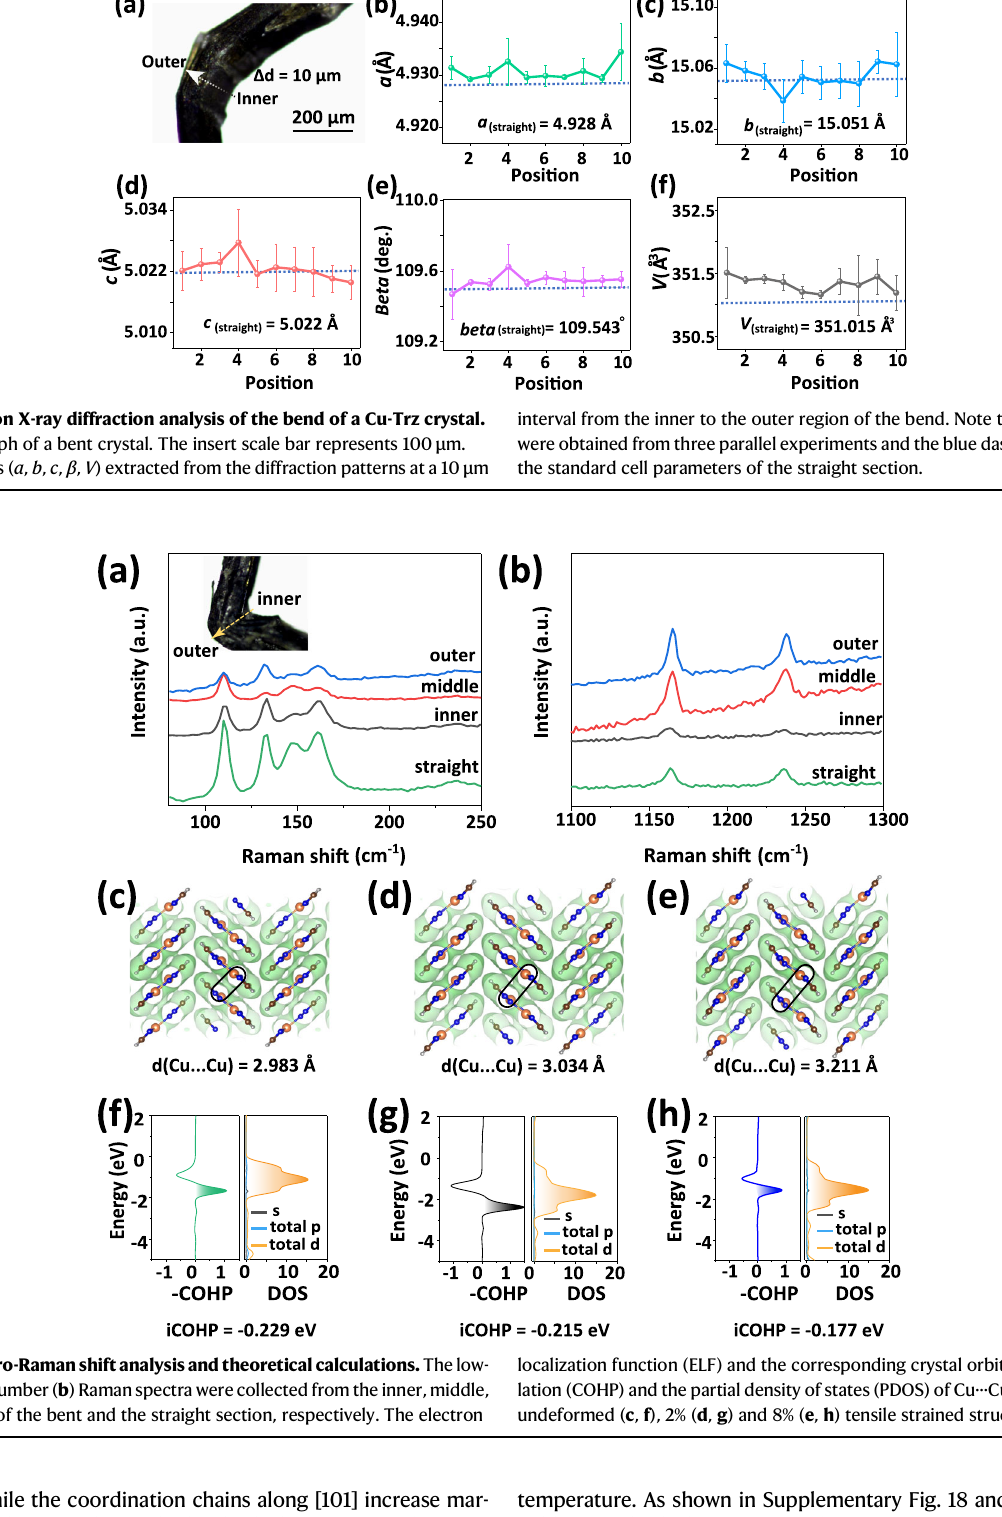
localization function (ELF) and the corresponding crystal orbital Hamilton popu- lation(COHP)andthepartialdensityofstates(PDOS)ofCu···Cuinteractionsofthe undeformed ( c , f ), 2% ( d , g ) and 8% ( e , h ) tensile strained structures.